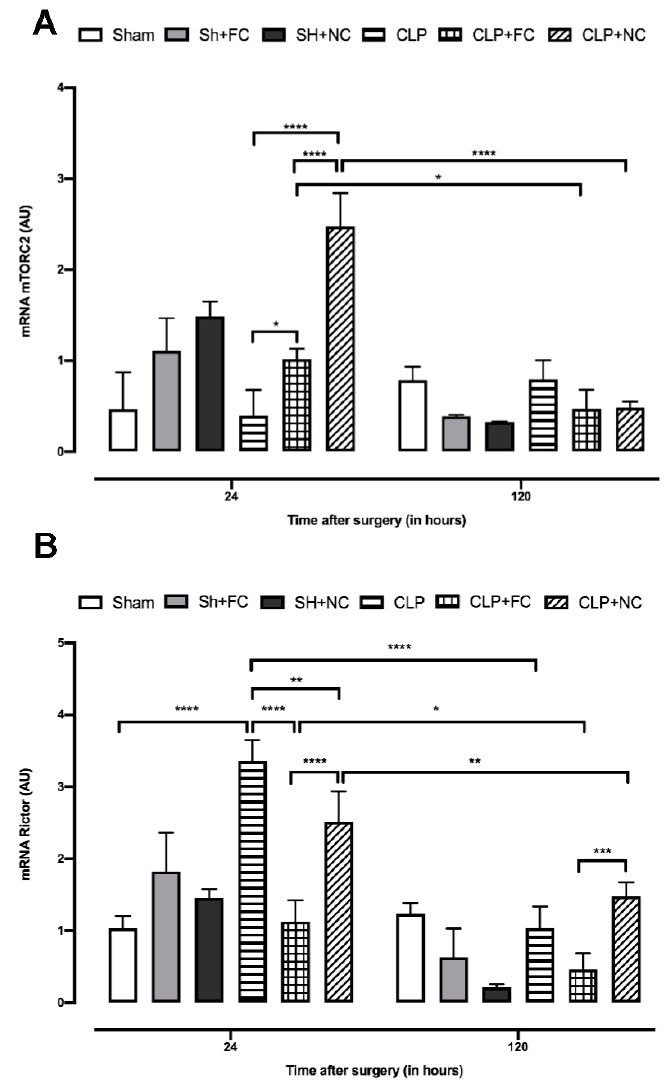
Figure 5. Real-time PCR gene expression profile analysis of mTOCR2 and Rictor in the heart of curcumin-treated and untreated septic animals. ( A ) The assessment of mTORC2 mRNA levels shows that the treated septic groups (CLP + FC and CLP + NC) had a significant increase ( p < 0.05 and p < 0.0001, respectively) compared to the untreated group (CLP) at 24 h. Analysis at 120